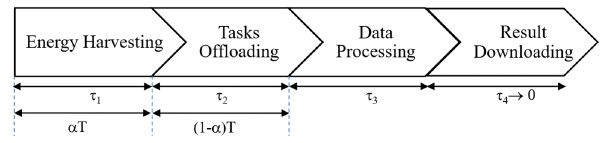
Figure 2. Time flowchart of the considered RF EH IRS- assisted MEC